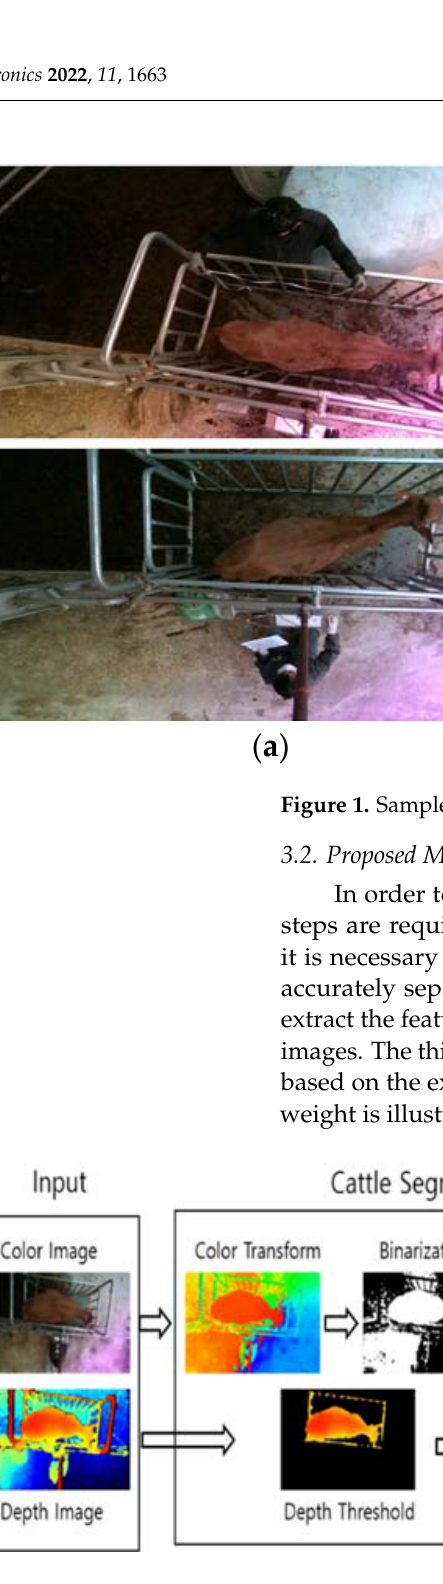
Figure 2. Overview of prediction system for cattle weight.